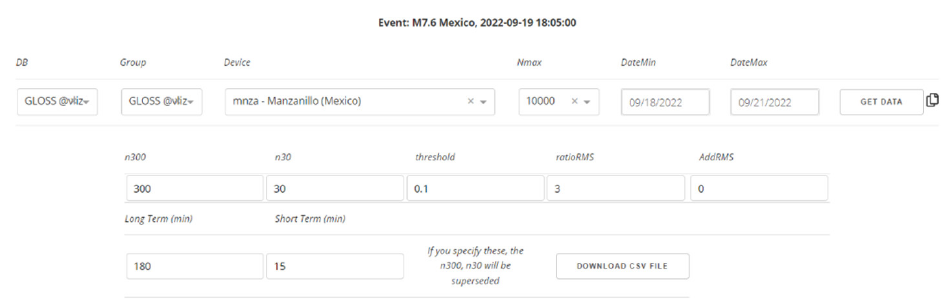
17 of 18 Figure A3. Screenshot of the SLM web site with the analysis of one particular signal measured for a specific event.